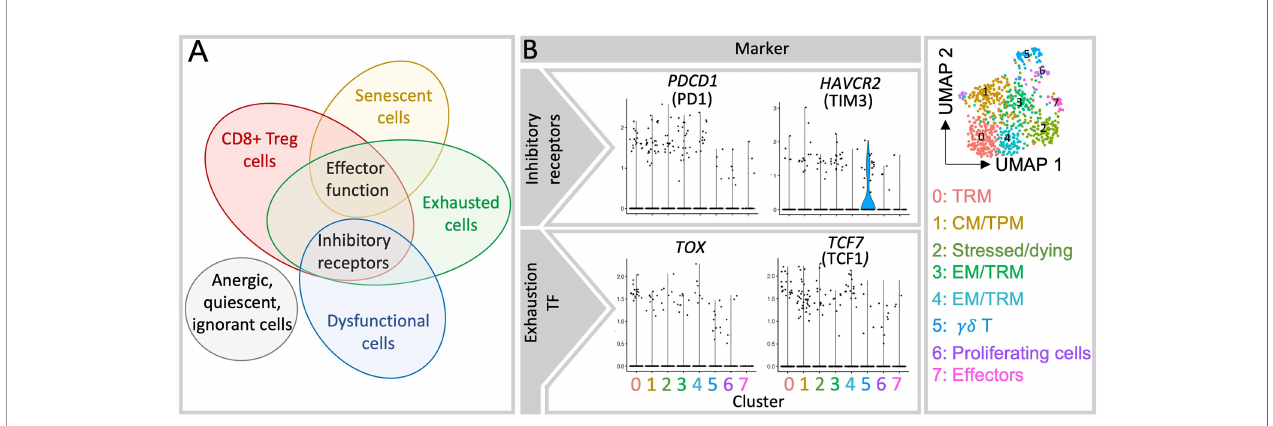
FIGURE 2 | Currently reported decidual CD8+ T cell subsets present overlapping features. (A) Expression of inhibitory molecules is present in multiple cell populations in the decidua and appears insuf fi cient to determine whether a given cell is exhausted, dysfunctional or has regulatory capabilities. Inhibitory receptors are co-inhibitory molecules that hinder T cell activation and functions, those include i.e. PD1, CTLA4, Tim3 (32). Effector function applies to activate CD8+ T cells that is mediated with i.e. secretion of effector cytokines and/or cytolytic molecules in order to resolve a given threat. (B) Violin plots show the gene expression of inhibitory receptors (PD1 and Tim3) and transcription factors associated with exhausted cells (TOX and TCF1) in each cluster, which fall in many of the clusters shown in the UMAP plot (right). TF, transcription